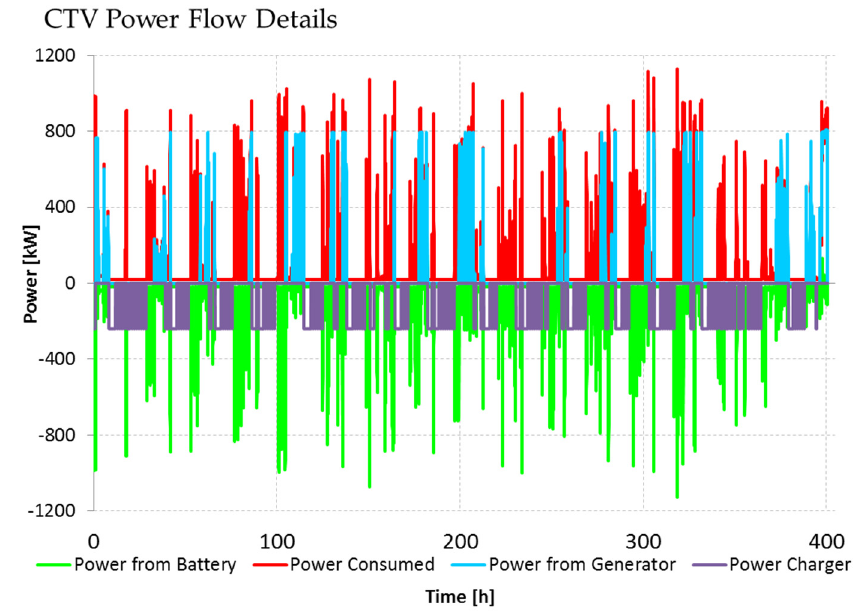
Figure 17. Plot of power flow between generators, battery and propulsion system.